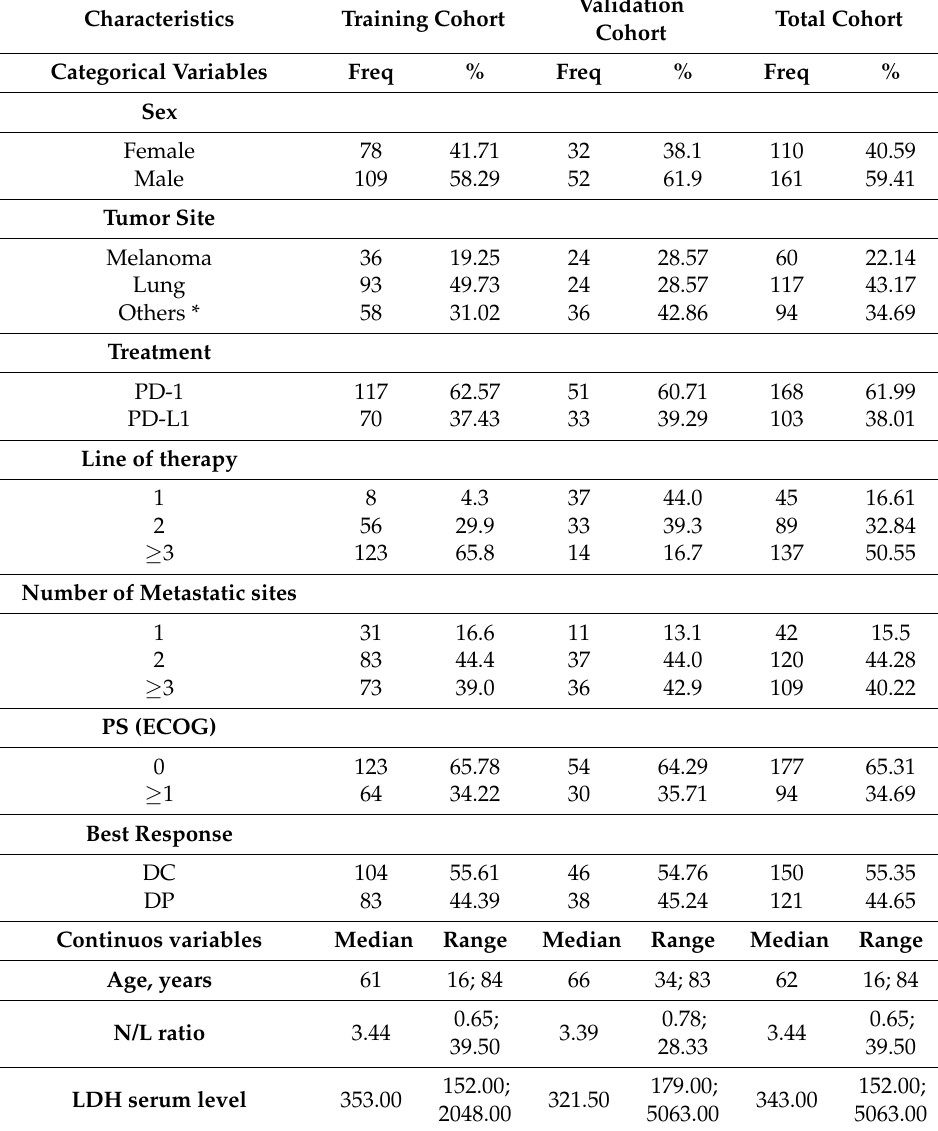
Table 1. Clinic-pathological characteristics: training, validation and total